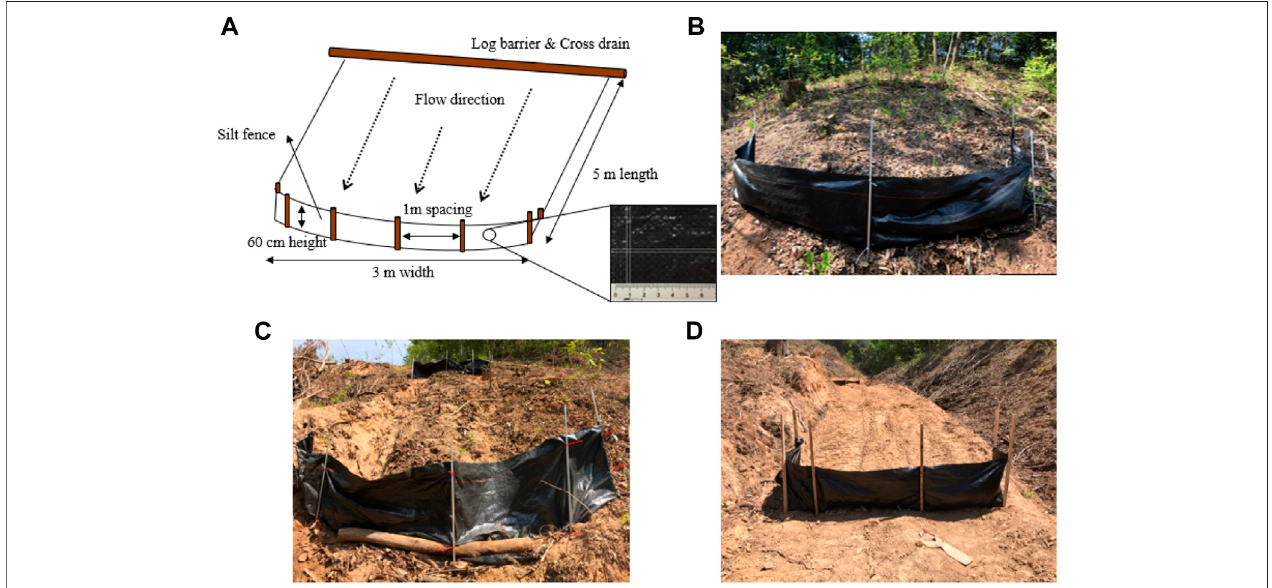
FIGURE4| Anexampleofthesiltfenceinstalledinthestudyarea. (A) Pro fi leofthesitefence, (B) anundisturbedandshallowdisturbedarea(US), (C) abladedskid trailbysmall-shovel loader passages (BT; tracked rutted trail), and (D) acompacted skidtrail (compacted road surfaces)bycarrier passageswithconstruction bysmall- shovel loader